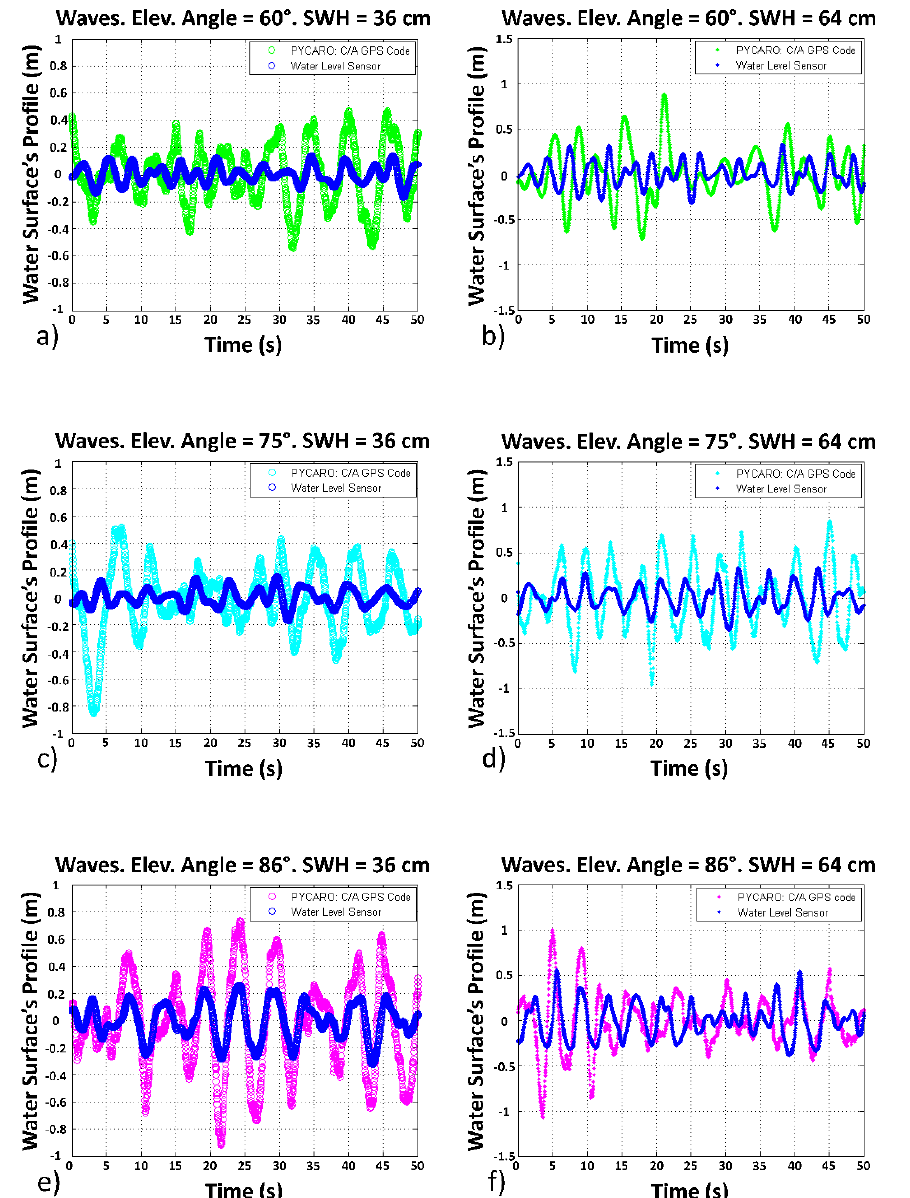
Figure 10. For an elevation angle of ( a , b ) θ = 60°, ( c , d ) θ = 75° and ( e , f ) θ = 86°, (a,c,e) e e e sample wave profile as measured by PYCARO using the GPS C/A code and by the water level sensor for a SWH = 36 cm and (b,d,f) for SWH = 64 cm. Additionally, the water surface’s spectra computed for the different surface states as measured by PYCARO for the different elevation angles ( θ = 60°, 75° and 86°) are represented in Figure 11a,c,e and e Figure 11b,d,f respectively, for a SWH = 36 cm and 64 cm. The Pearson’s linear correlation coefficients of the level gauge sensor and the bistatically-derived results are 0.78, 0.85 and 0.81 for a SWH = 36 cm and 0.34, 0.74 and 0.72 for a SWH = 64 cm, θ = 60°, 75° and e